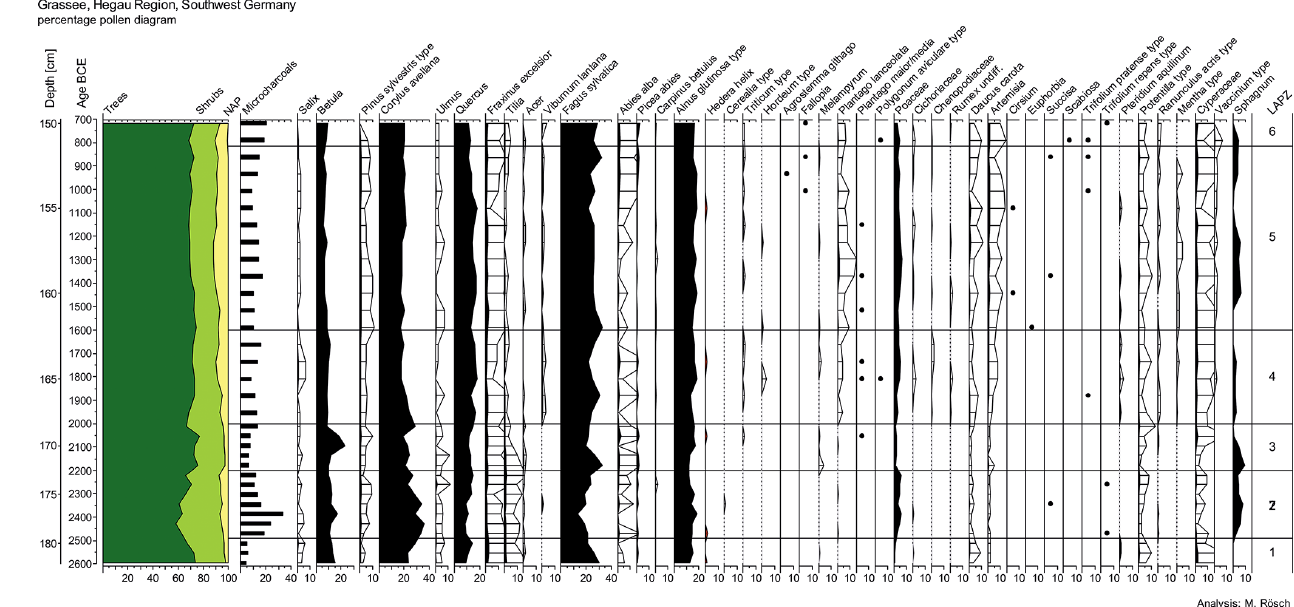
Figure 13. Pollen profile of Grassee mire. NAP: non-airborne pollen. The samples were investigated in increments of 1cm.